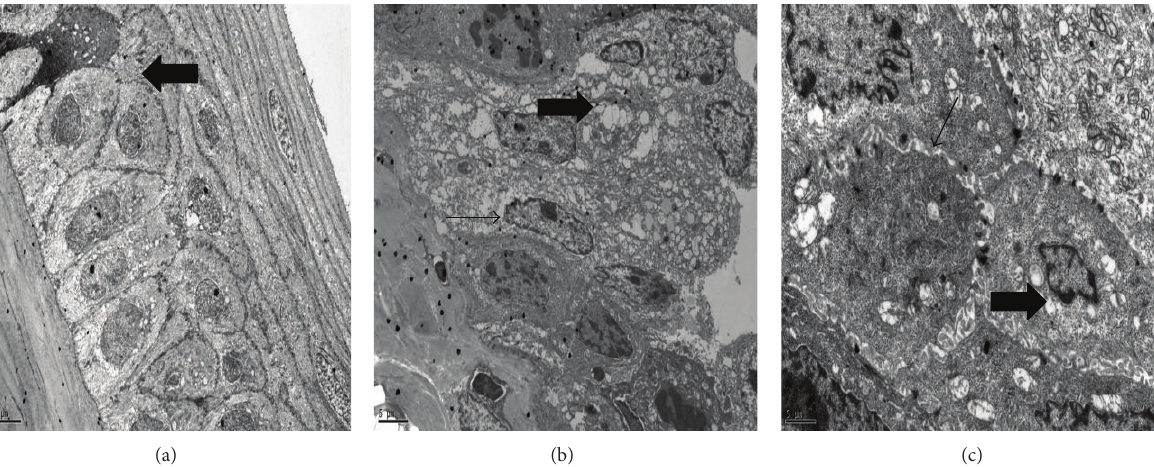
Figure 5: Transmission electron microscopy findings of cellular injury observed in PBS-treated rats. Apoptotic cell (arrows) observed in PBS- treatedratcornea(a).Swellingofcellsandlyticfocusesincellcytoplasms(thickarrow)wereobserved.Condensationofmitochondrialmatrix, dilatation of smooth endoplasmic reticulum, and decreased secretory granules (thin arrow) were observed in cells (b). Peripheral migration, condensation of chromatins, and irregular expansion of perinuclear cisternas (thick arrow) were observed in nucleus of cells although there were intact desmosomes (thin arrow) between cells (c) (Joel JEM-1400 model, magnification (a), (b): × 5000 and (c): × 12000).